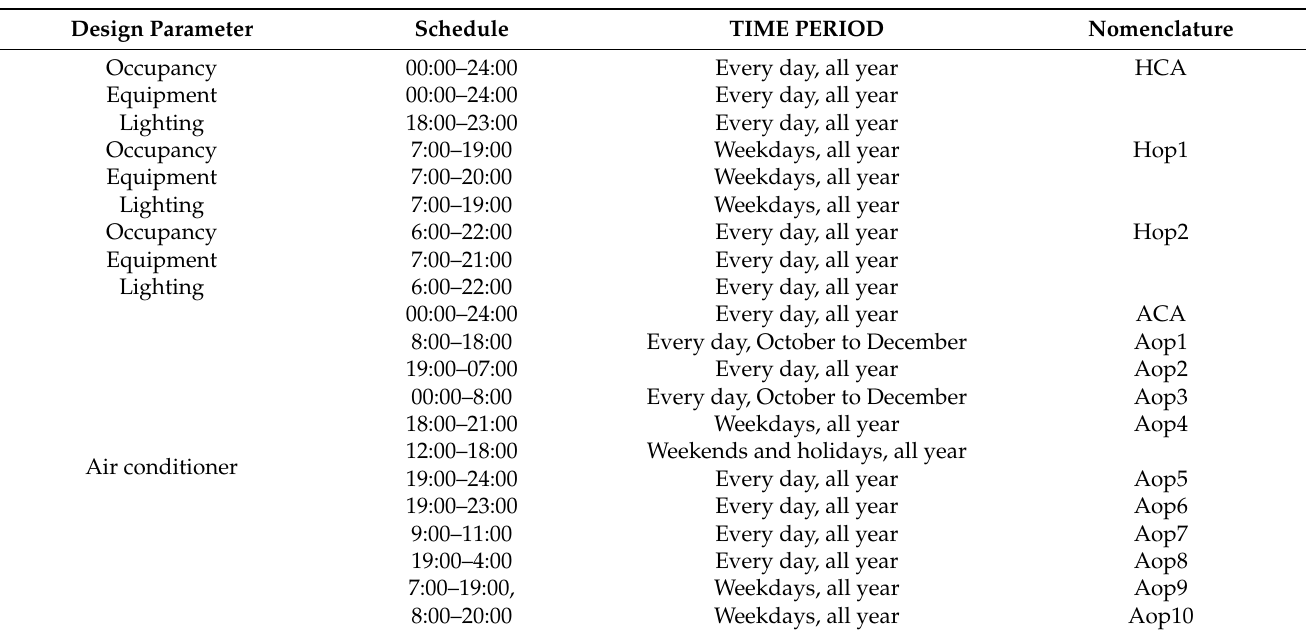
Table 5. Original occupancy, equipment, lighting and air conditioning schedules and design options obtain from optimization